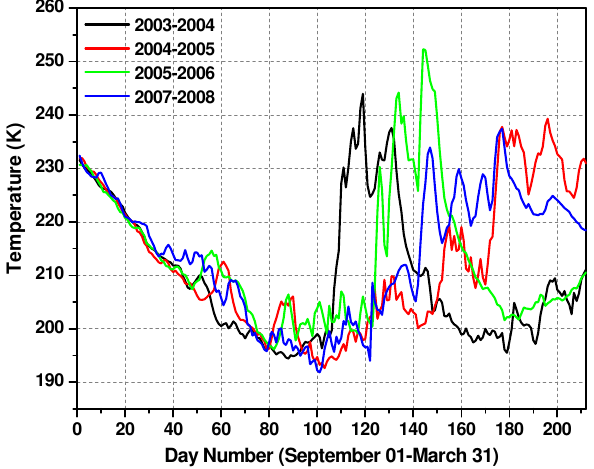
Fig. 1. Daily variation of daymean Polar Stratospheric Tempera- ture (at 10hPa) during the SSW years (2003–2004), (2005–2006) (2007–2008) and (non-SSW year (2004–2005).